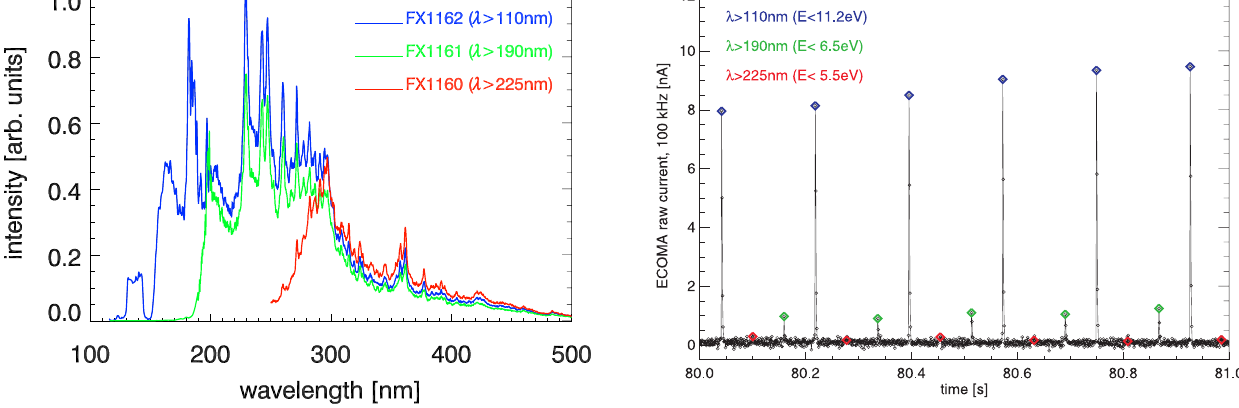
Fig. 2. Spectra of the different flash lamp types used in the improved version of the ECOMA particle detector. These spectra have been obtained with a vacuum ultraviolet grating spectrometer (see Ernst, 2012, for more details).